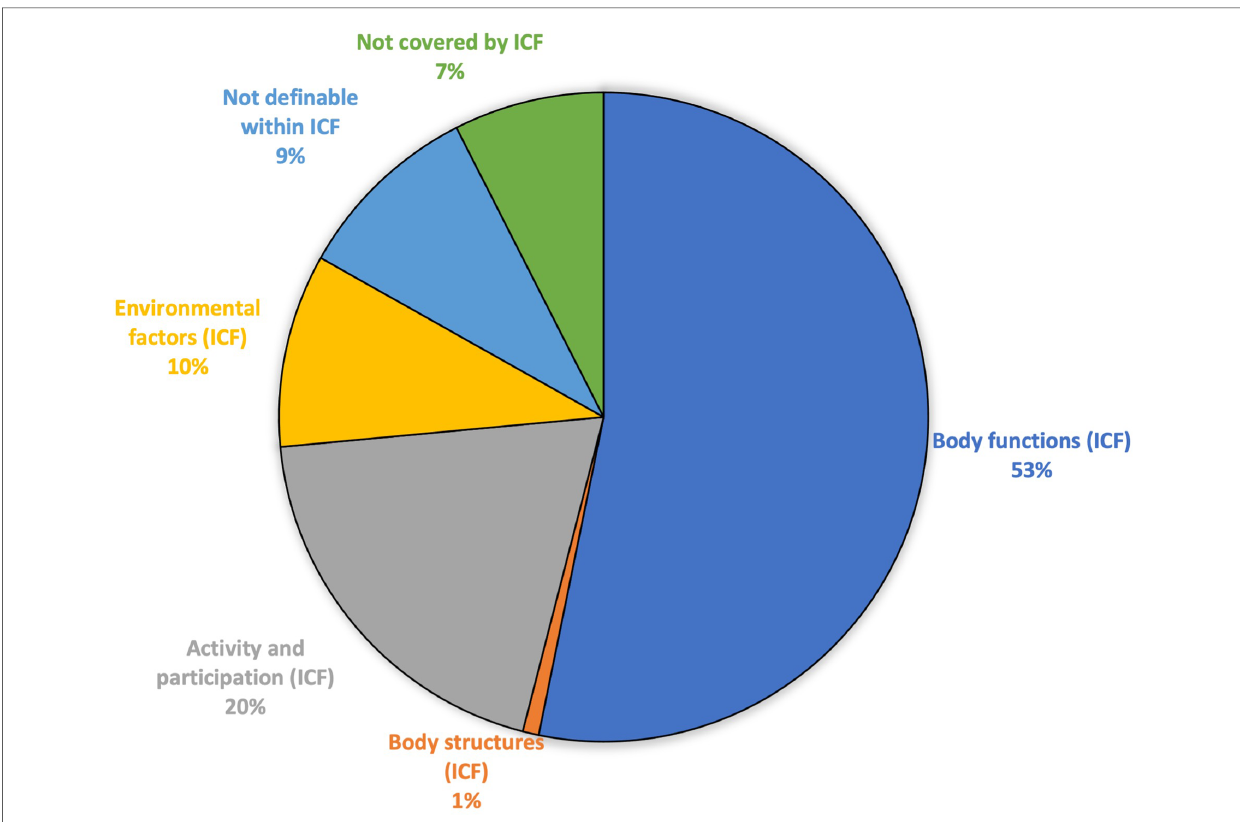
FIGURE 2 Result of the ICF linking of sick leave certi fi cates issued for depression, in terms of the number of codings of ICF categories and other health information not possible to link to